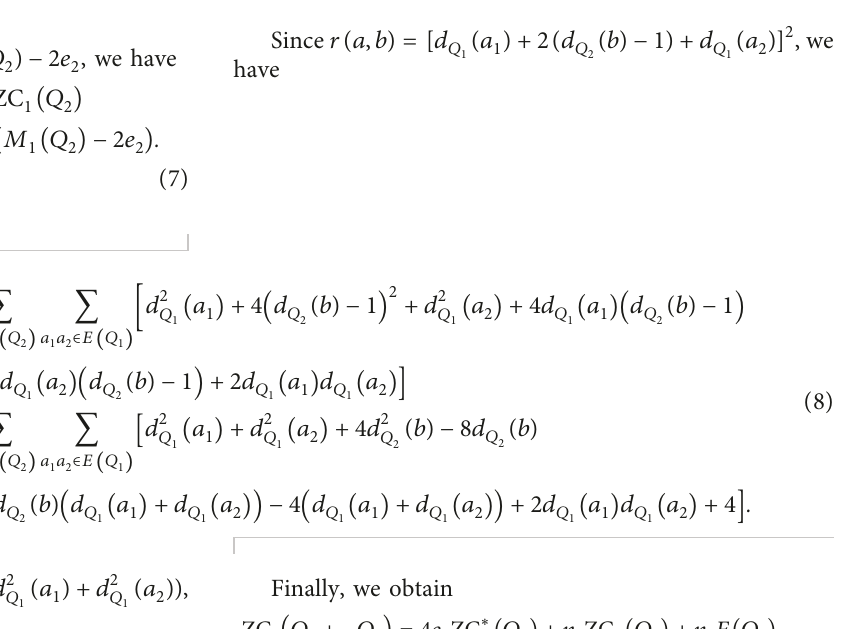
Figure 2: (a) Q S � S